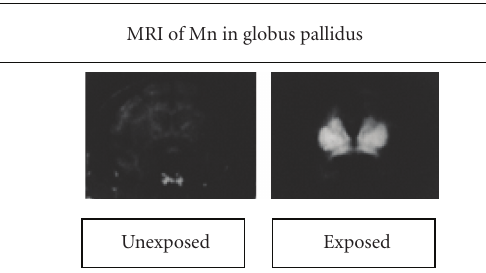
Figure 2: Magnetic resonance images of two monkeys, one exposed to inhaled manganese and one contol. They show that manganese achieves high concentrations in the global pallidus. Based on Newland and Weiss [12].